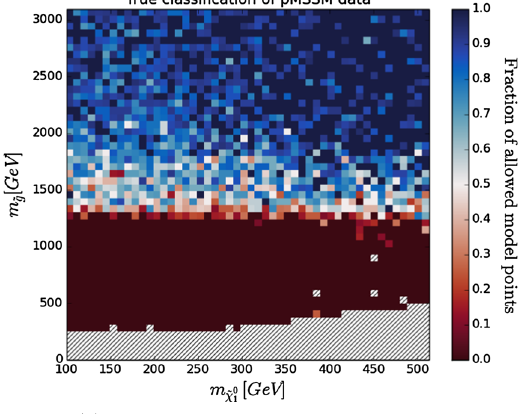
the same plane as a , b after applying a constraint on the stop mass to filter out data points mimicking natural SUSY. The dashed bins contain no data points. The dashed stripe in a , b corresponds to the points that were outside the 95% CL boundaries of CheckMATE ; see